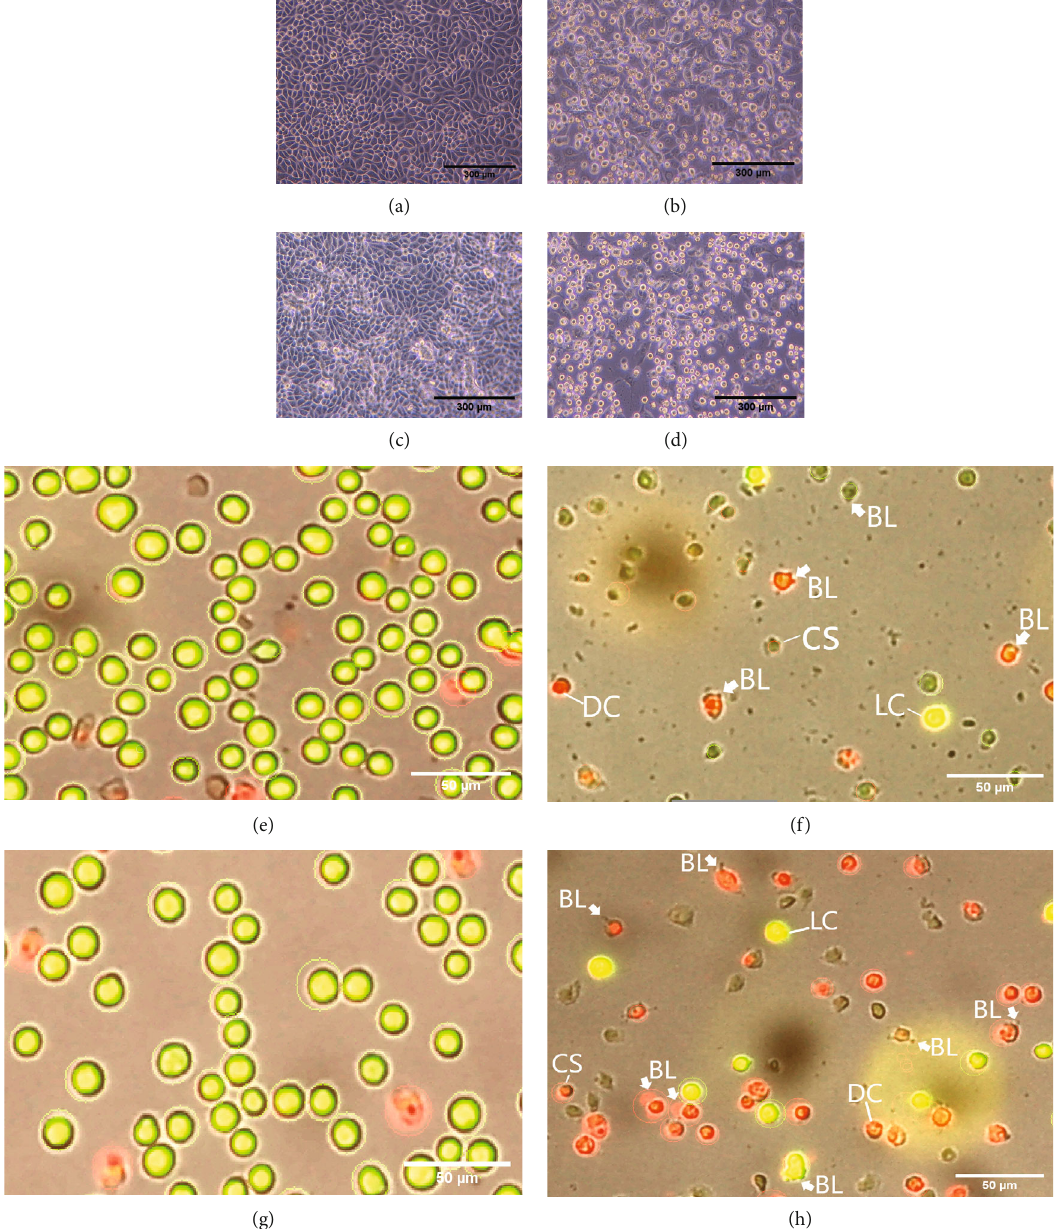
Figure 4: Breast cancer cells under the inverted microscopic view and on the screen view of Luna-FL. Microscopic view for MDA-MB-231 (control: (a), treated: (b)), MCF-7 (control: (c), treated: (d)). Luna-FL on-screen view of AO/PI-stained MDA-MB-231 (control: (e), treated: (f)), MCF-7 (control: (g), treated: (h)). LC: live cells; DC: dead cells; LB: membrane blebbing; CS: cell shrinkage. Cells were treated with